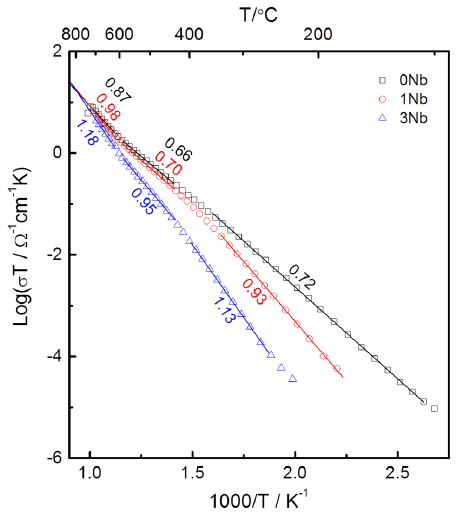
Figure 6. dc conductivity vs. 1/temperature for 0.4(K 0.5 Bi 0.5 )Ti (1 − x ) Nb x O 3 ‐ 0.6BiFe (1 − x ) Nb x O 3 samples sintered at 1050 °C for 1 h.